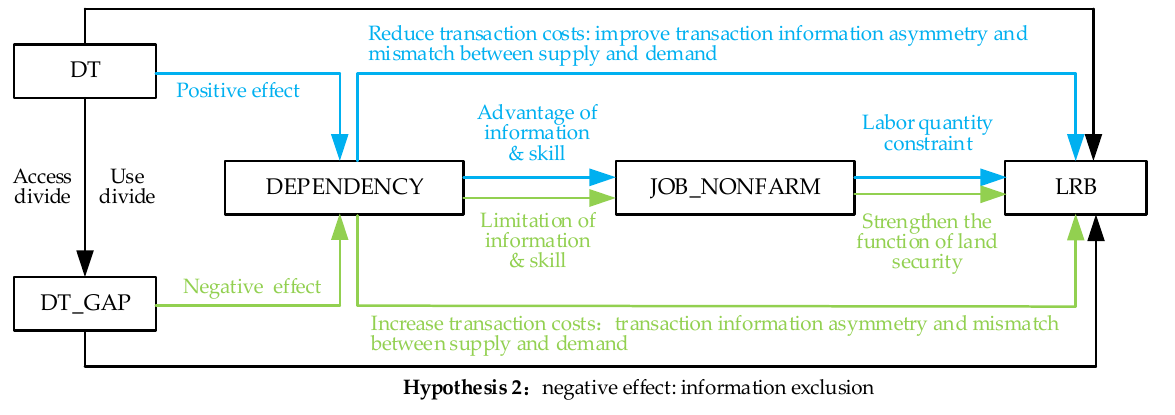
Figure 1. Theoretical analysis framework diagram: impact of DT on LRB.